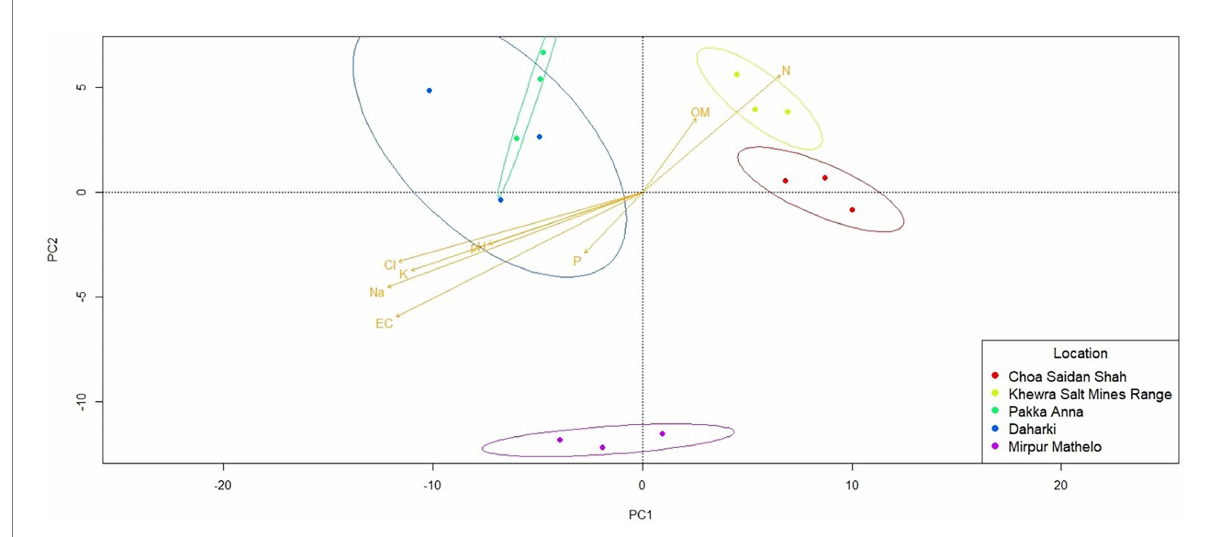
FIGURE 5 Differences in the predicted metagenome of soil microbial communities in five soils collected from agricultural fields within the Indus River Basin, Pakistan, and correlations with chemical properties quantified using principal coordinates analyses (PCA). EC, Electric conductivity; OM, total organic matter; P, exchangeable phosphorous; CL, total concentrations of chloride; K, potassium; Na, sodium; N,